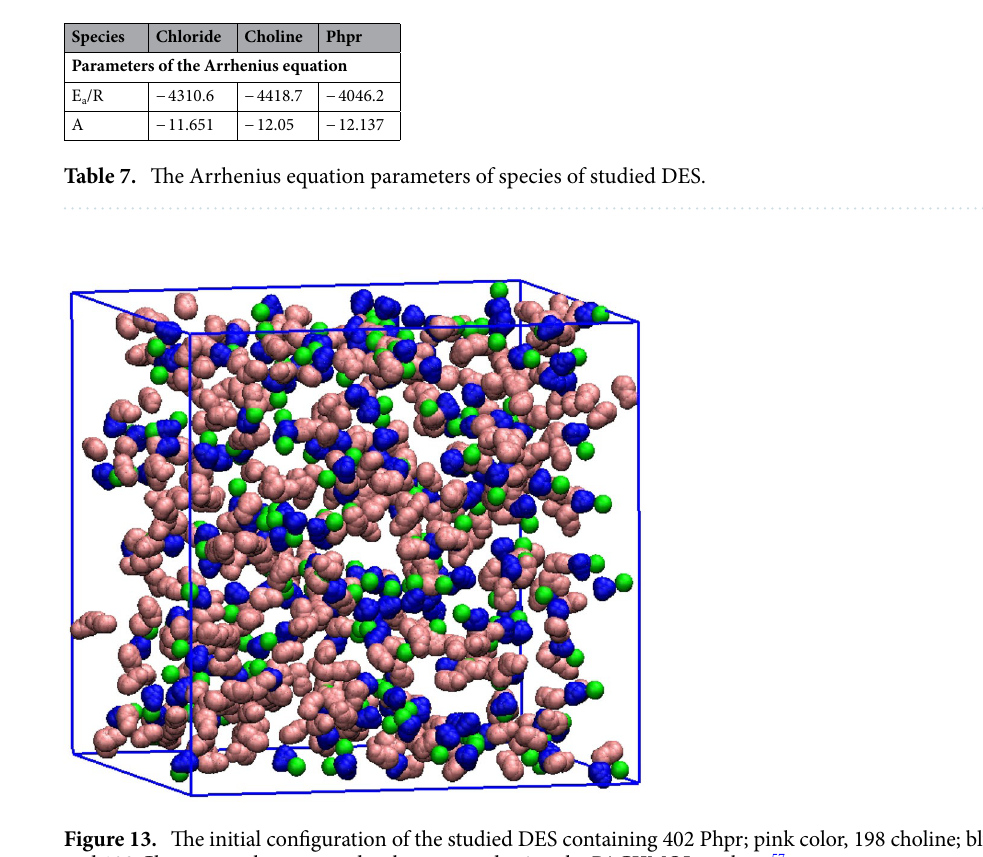
Figure 13. The initial configuration of the studied DES containing 402 Phpr; pink color, 198 choline; blue color, and 198 Cl − ; green color was randomly generated using the PACKMOL package 57